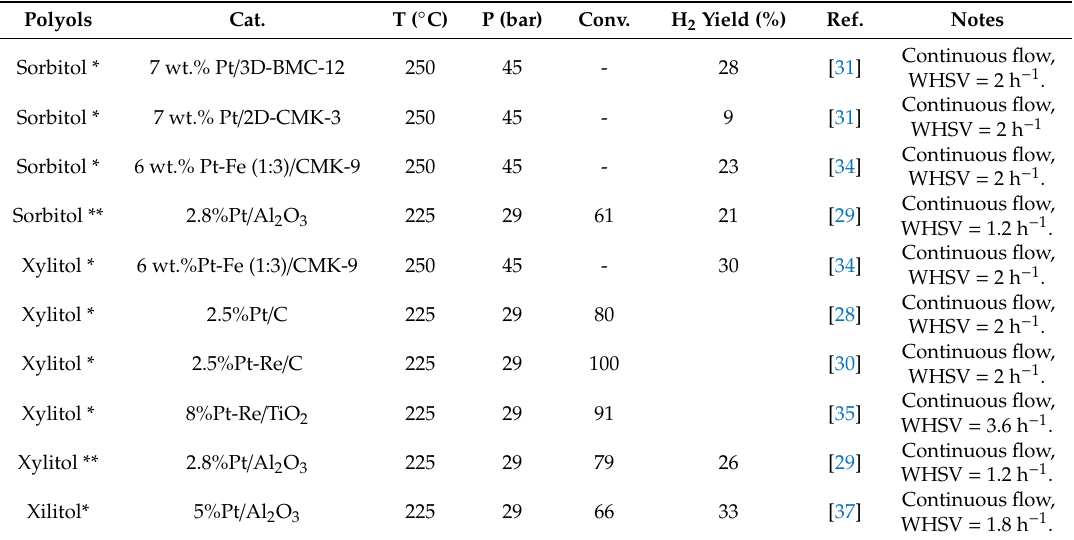
Table 1. Results of aqueous phase reforming of di ff erent